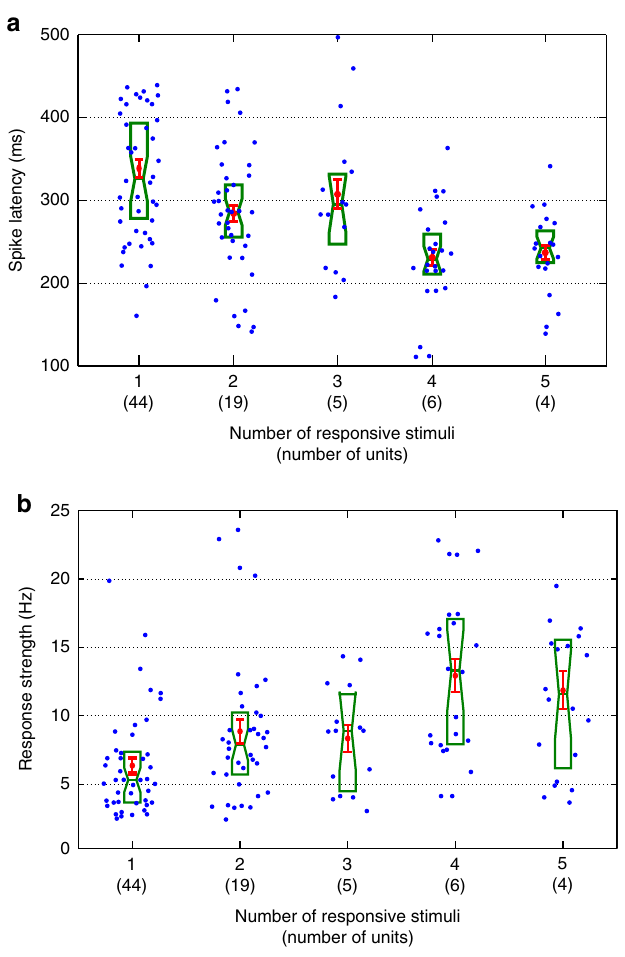
Fig. 7 Neural unitization as a mechanism for encoding associations in the human MTL. a Spike response latency was signi fi cantly correlated with the number of response-eliciting stimuli (Spearman correlation, ρ = − 0.45, p ~ 10 − 8 ). Each dot represents an individual response. Mean± standard error of the mean are shown in red, whereas boxplots are in green (center line, median; box limits, upper and lower quartiles; notch limits, (1.57 × interquartile range)/sqrt( n )). b Same as a but showing that multi- responsive neurons have a larger response strength (Spearman correlation, ρ = 0.43, p ~ 10 − 7